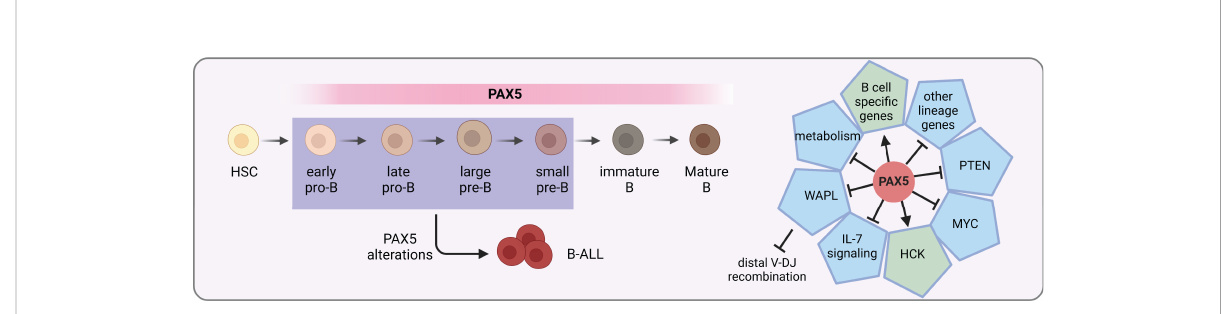
FIGURE 1 PAX5 functions in B cell development. PAX5 is expressed during the whole B cell developmental stages. It activates the expression of B cell speci fi c genes, while at the same time represses the expression of other lineage genes to initiate and maintain the B cell identity. In MYD88-driven B-cell lymphomas, it activates the pro-survival kinase HCK (21). In addition, it activates PI3K signaling via PTEN inhibition to stimulate follicular B cell proliferation (22). Furthermore, PAX5 safeguards leukemic transformation by limiting glucose and energy supply, inhibiting IL-7 signaling as well as MYC expression (23 – 25). Finally, PAX5 also has an essential role in the V(D)J recombination of the IgH locus by repressing WAPL expression (26). PAX5 alterations with compromised activity can lead to developmental arrest of B cells, which are commonly seen in